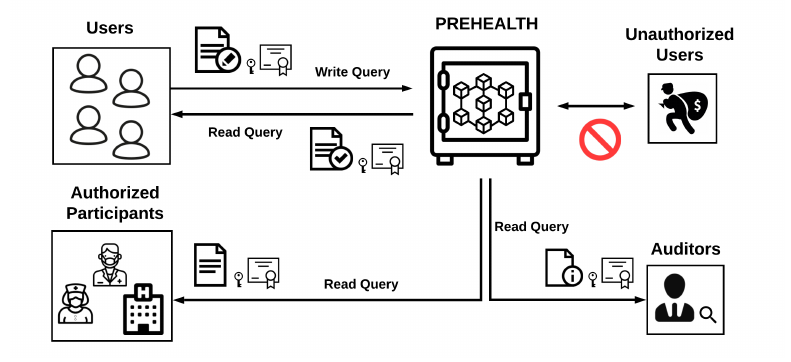
Figure 1. Privacy-Preserving Healthcare